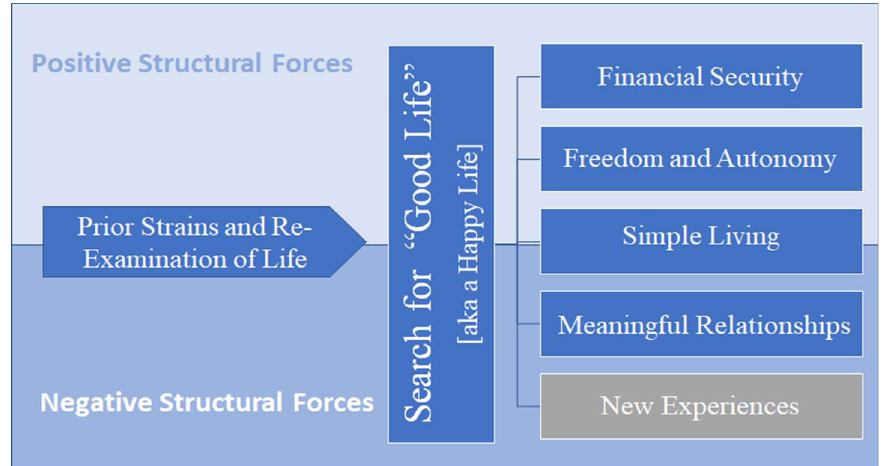
Figure 1. Simple conceptual model for the tiny house (TH) lifestyle appeal.